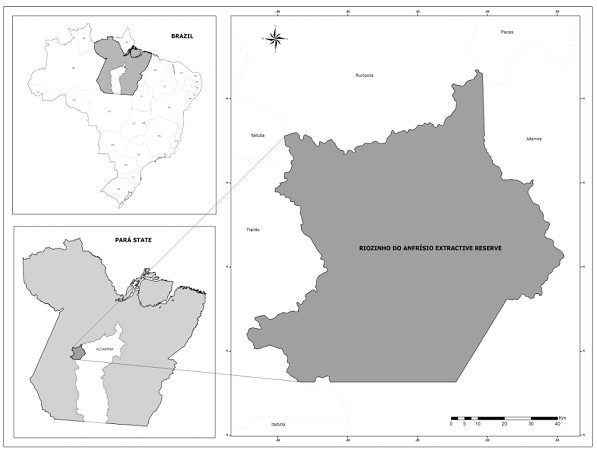
Map of the studyarea. Map of the “Riozinho do Anfrísio” Extractive Reserve, State of Pará, Brazil.